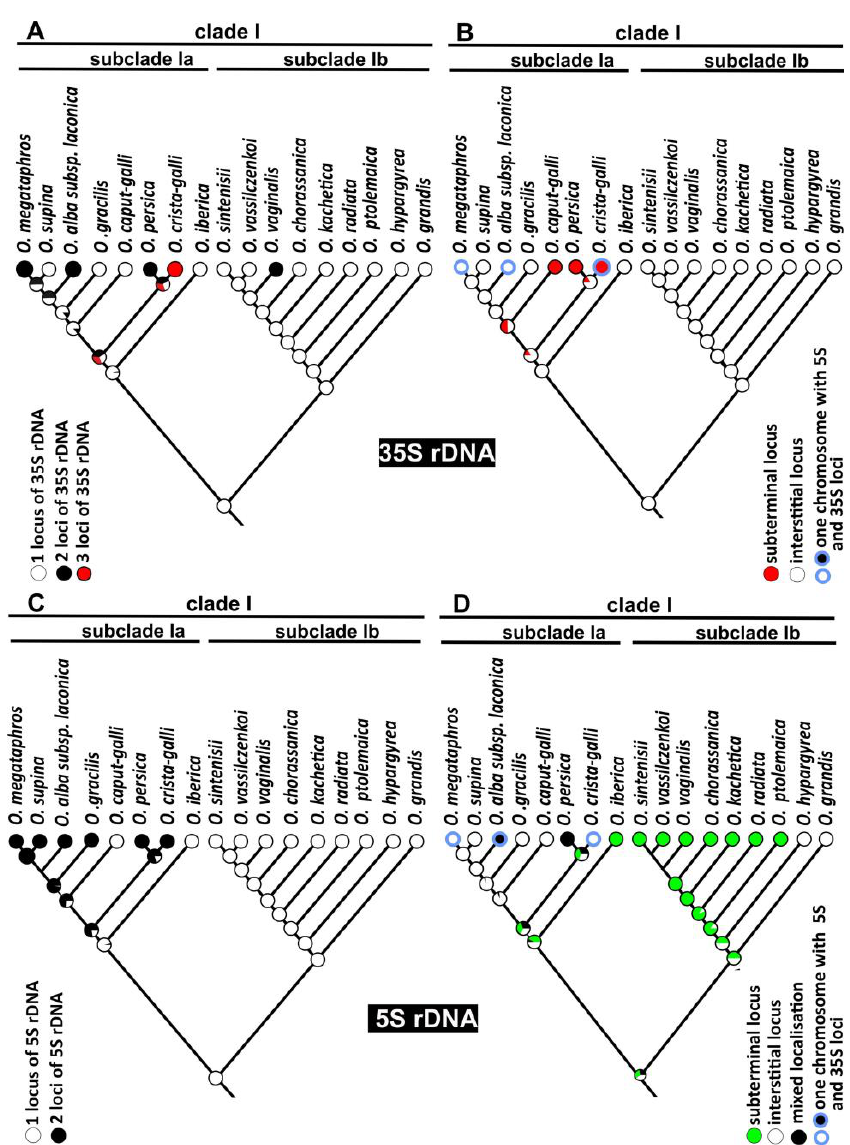
Figure 4. Ancestral character state reconstruction of the rDNA locus number and localisation for Onobrychis species. The numbers and localisation of the rDNA loci were mapped onto the ML tree of the nrITS sequences using maximum likelihood methods. ( A ) The number of 35S rDNA loci. ( B ) Localisation of 35S rDNA loci. ( C ) The number of 5S rDNA loci. ( D ) Localisation of 5S rDNA loci. The tree was rooted with Hedysarum candidissimum , which was subsequently removed from the